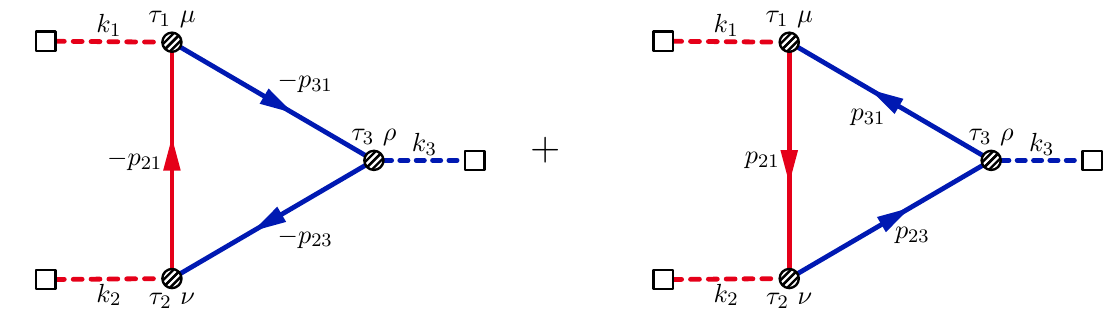
Figure 8 . Feynman diagrams showing the main contributions to the 3-point function for the in(cid:13)aton. The in(cid:13)aton and fermion lines highlighted in red (blue) highlight the hard (resp. soft) momenta in the squeezed